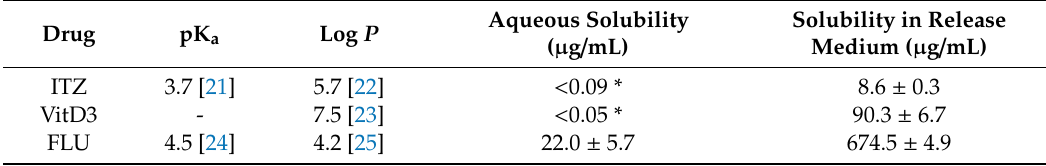
Table 1. The physicochemical properties of model